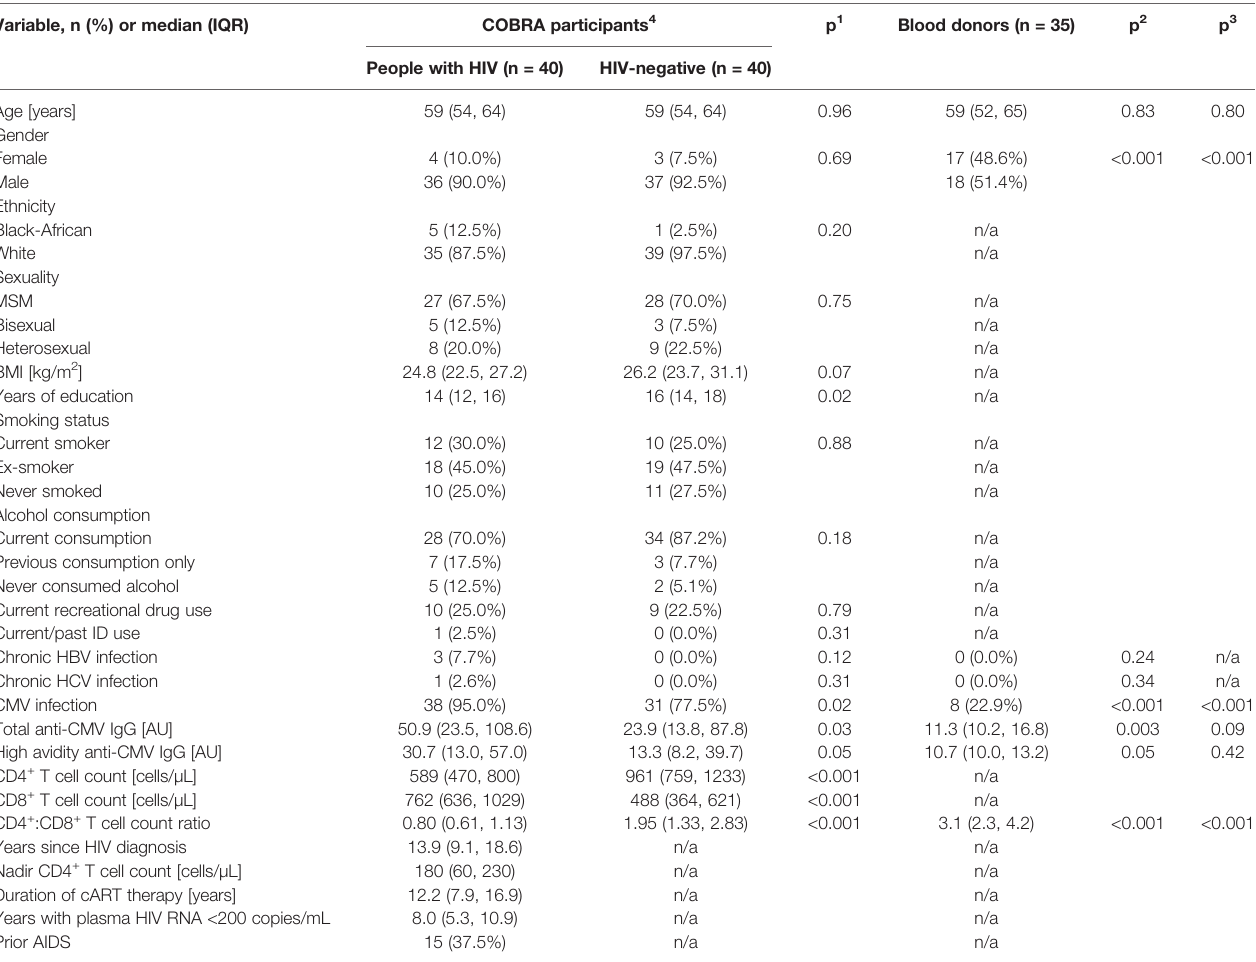
TABLE 1 | Characteristics of study